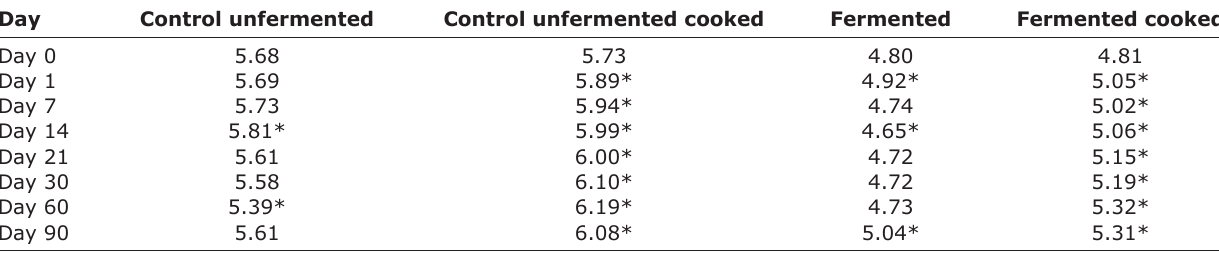
Table-1: Average pH of fermented and unfermented pork sausage with and without cooking. Day Control unfermented